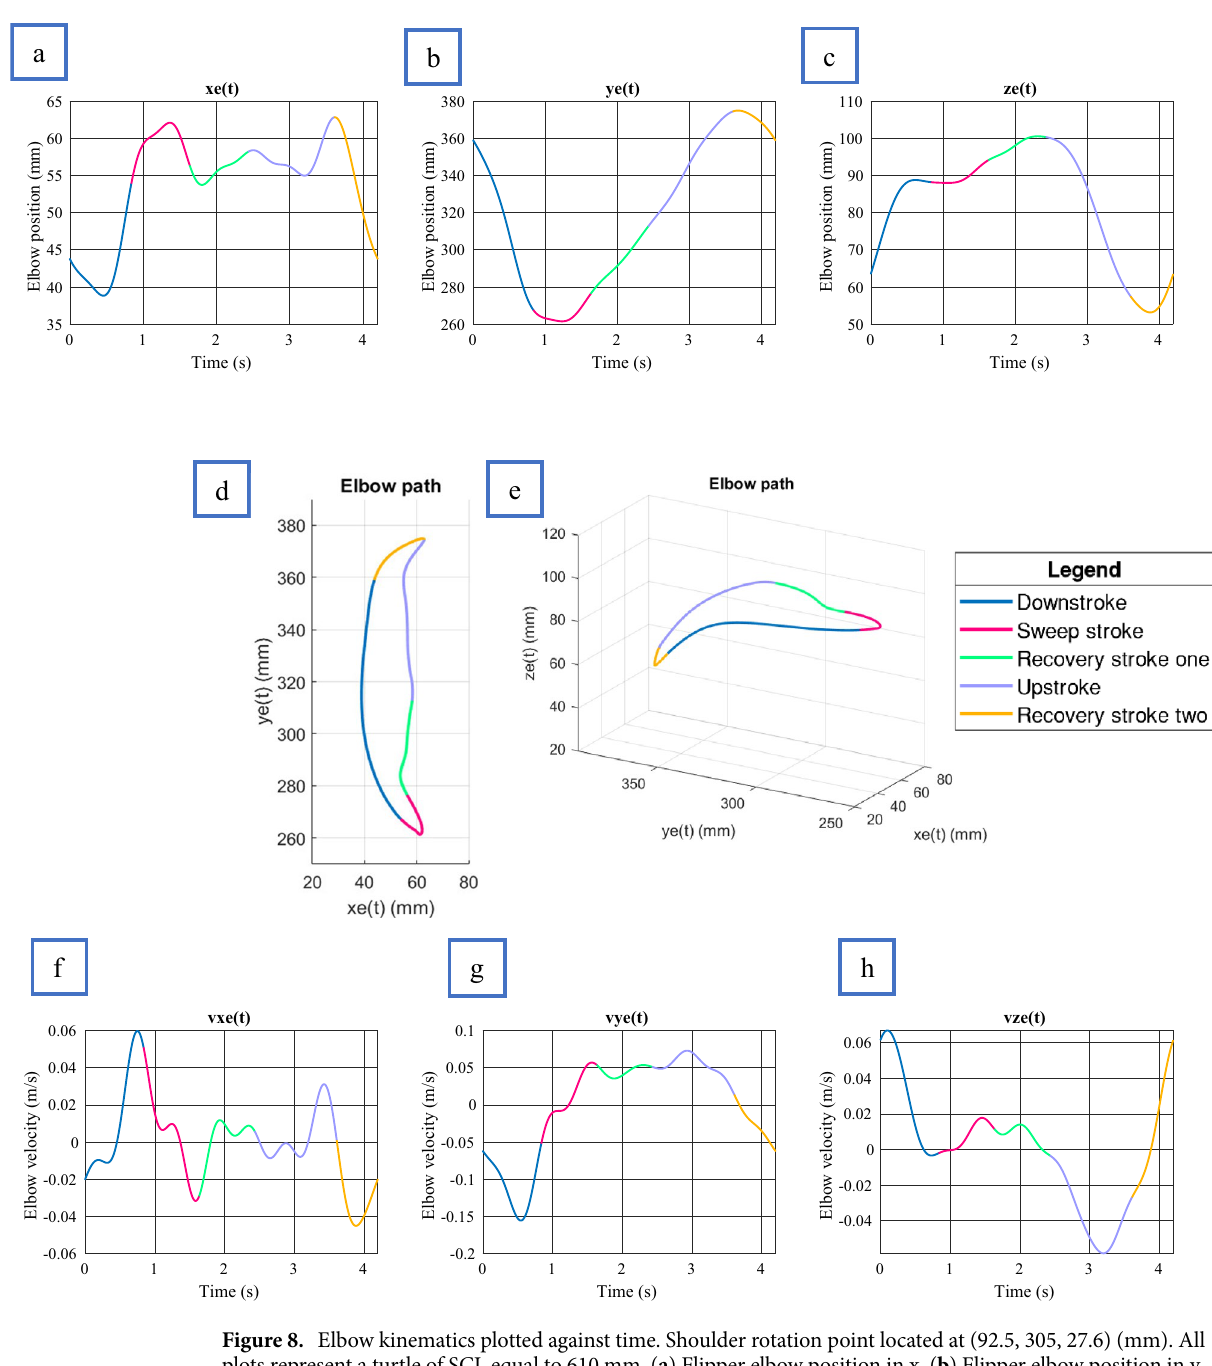
Figure 8. Elbow kinematics plotted against time. Shoulder rotation point located at (92.5, 305, 27.6) (mm). All plots represent a turtle of SCL equal to 610 mm. ( a ) Flipper elbow position in x, ( b ) Flipper elbow position in y, ( c ) Flipper elbow position in z, ( d ) Flipper elbow path in x, y plane. ( e ) Flipper elbow path 3D. ( f ) Flipper elbow velocity in x, ( g ) Flipper elbow velocity in y, ( h ), Flipper elbow velocity in